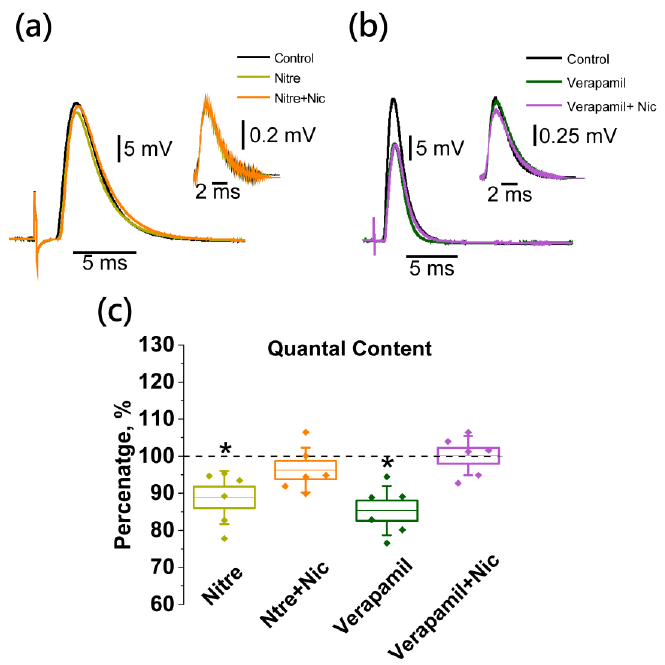
Figure 7. Nicotine-induced decrease in the ACh release (quantal content, QC) involves L-type Ca v 1 channels. Panels on the top are representative traces of EPP and mEPP (50 signals averaged) from individual experiments: ( a ) and ( b ) lack of nicotine (Nic, 10 µM) effect after pre-application with the Ca v 1 VGCC blockers nitrendipine (Nitre, 25 µM) and verapamil (50 µM); ( c ) mean ± SEM and SD of QC, expressed as a percentage of control or value after Nitre ( n = 6), Nitre plus Nic ( n = 6), Verapamil ( n = 6) and Verapamil plus Nic ( n = 6) application. Asterisks (*) indicate significant effects ( p < 0.05, one-way repeated ANOVA test with Tukey’s post-hoc comparison).